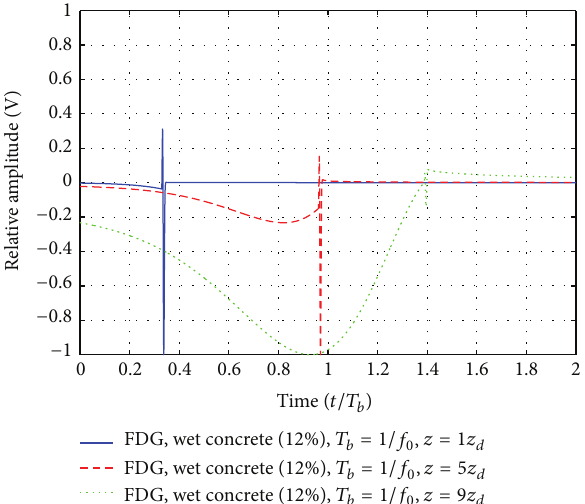
Figure 6: Normalized electric field evolution through different propagation distances within a dielectric slab of wet concrete (12% moisture content) for a FDG pulse with 𝑓 = 1.5 GHz and 𝑇 𝑏 = 1/𝑓 0